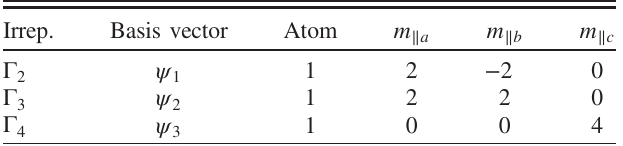
Ground-state energies of models 3 and 4 are identical. For these models, Heisenberg NN ( J 1 ) and out-of-plane NNN ( J 0 2 ) exchange terms cancel at the mean-field level and the ¯4 m 2 with system is effectively a two-dimensional Heisenberg square